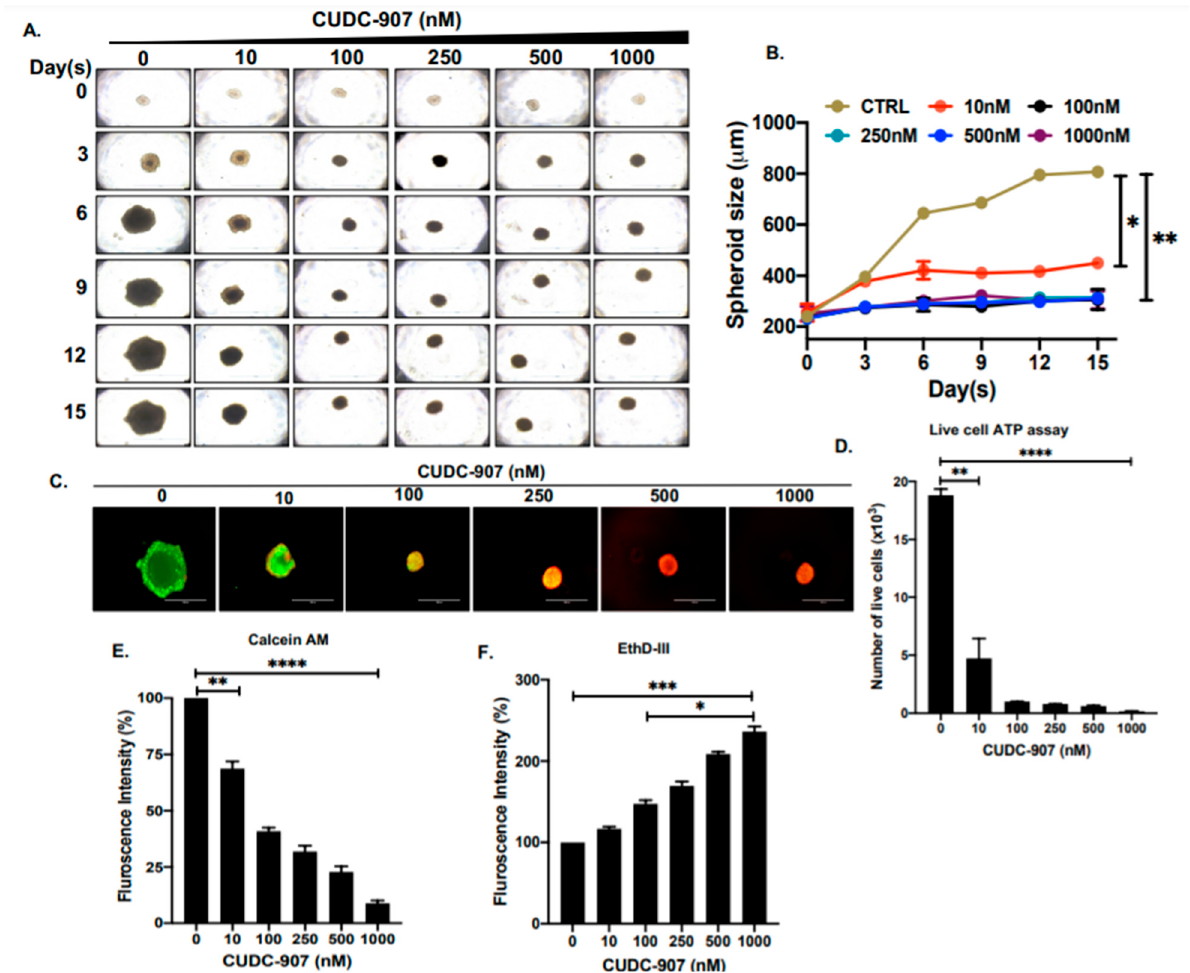
Figure 5. CUDC ‐ 907 inhibits NB spheroid tumor growth. ( A ) 3D spheroid tumors developed using SH ‐ SY5Y cell line at different days of growth in response to increasing concentrations of CUDC ‐ 907 treatment. ( B ) Spheroid tumor growth measurements as displayed in ( A ), show a significant decrease in spheroidal mass in response to CUDC ‐ 907 treatments. ( C ) Representative images of terminal spheroids stained with Calcein AM (green; live cells) and EthD ‐ III (red; dead cells) fluorescence dyes. ( D ) Quantitative assessment of the number of live cells in 3D spheroid tumors using live ‐ cell ATP release assay. ( E ) Quantitative representation of the percentage of cells stained with Calcein AM shows a significant decrease in the number of live cells. ( F ) Quantitative representation of the percentage of cells stained with EthD ‐ III shows a significant increase in the number of dead cells. * p < 0.05, ** p < 0.01. *** p < 0.001, **** p < 0.0001.